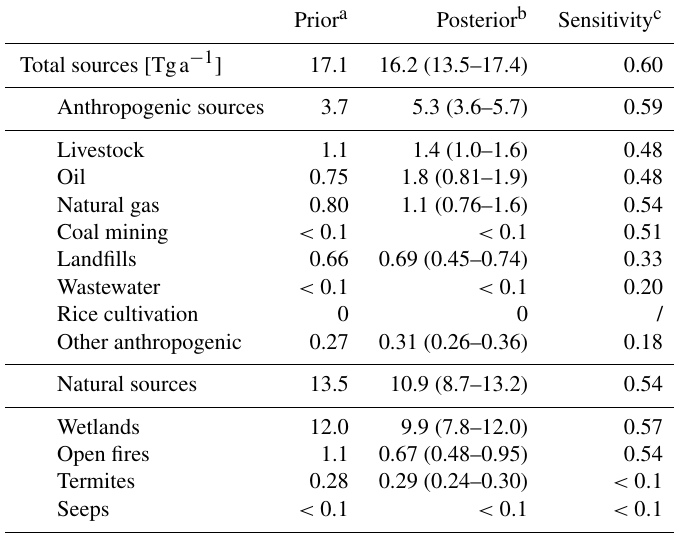
Table 1. (b) Mean 2010–2017 methane emissions for